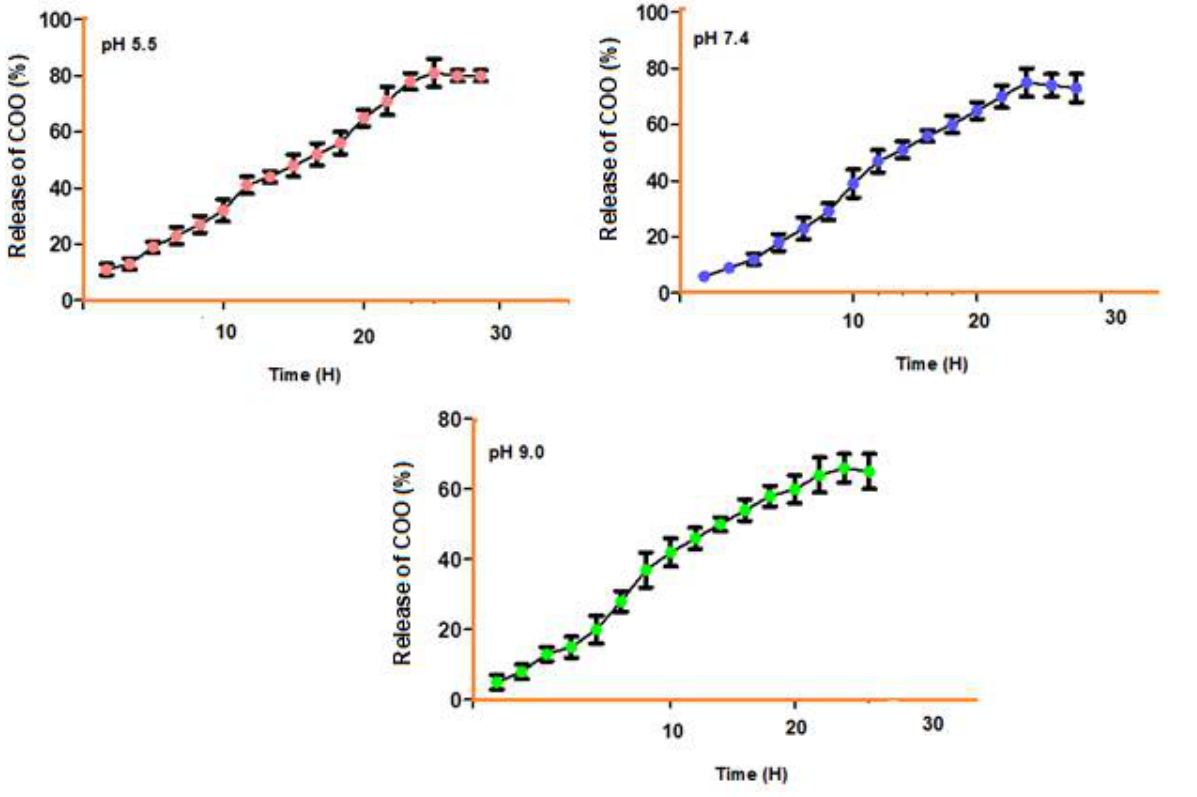
Figure 7. Release profiles of COO extract from GA-COO-SeNPs at various pH levels (5.5, 7.4, and 9.0).